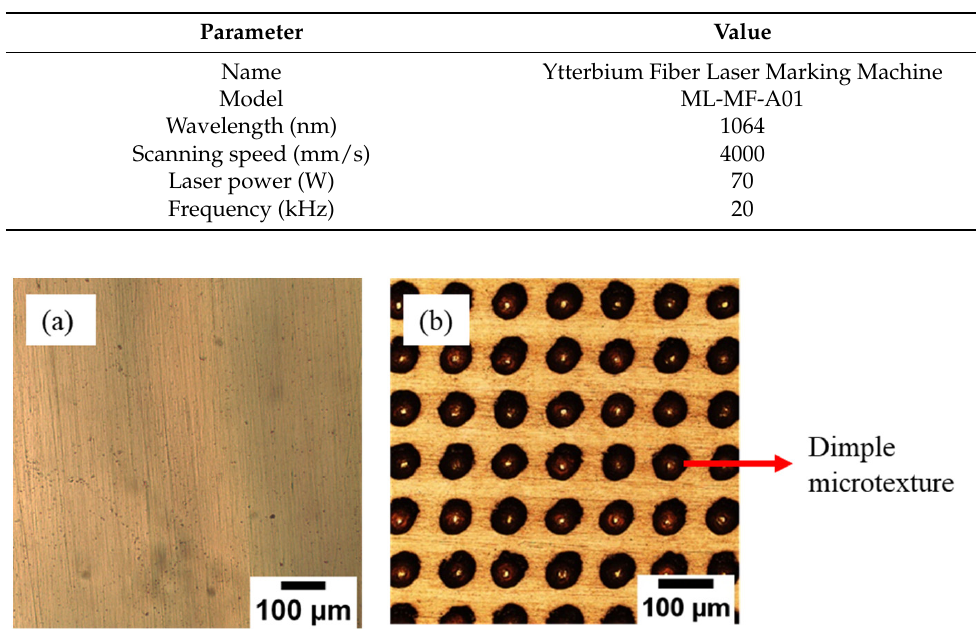
Table 1. Laser surface texturing parameters.